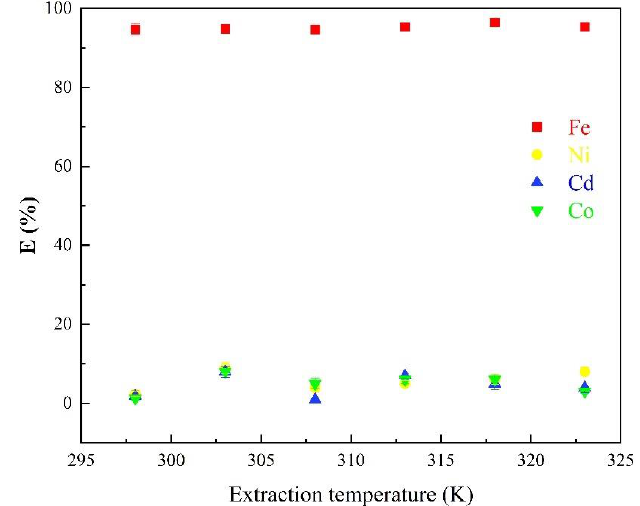
Figure 5. Effects of extraction temperature under the conditions: [D2EHPA] = 1 mol/L, saponification rate = 70%, initial [Fe 3+ ] = 12.25 g/L, extraction time = 20 min, initial pH = 1.00, and phase ratio = 1:1.